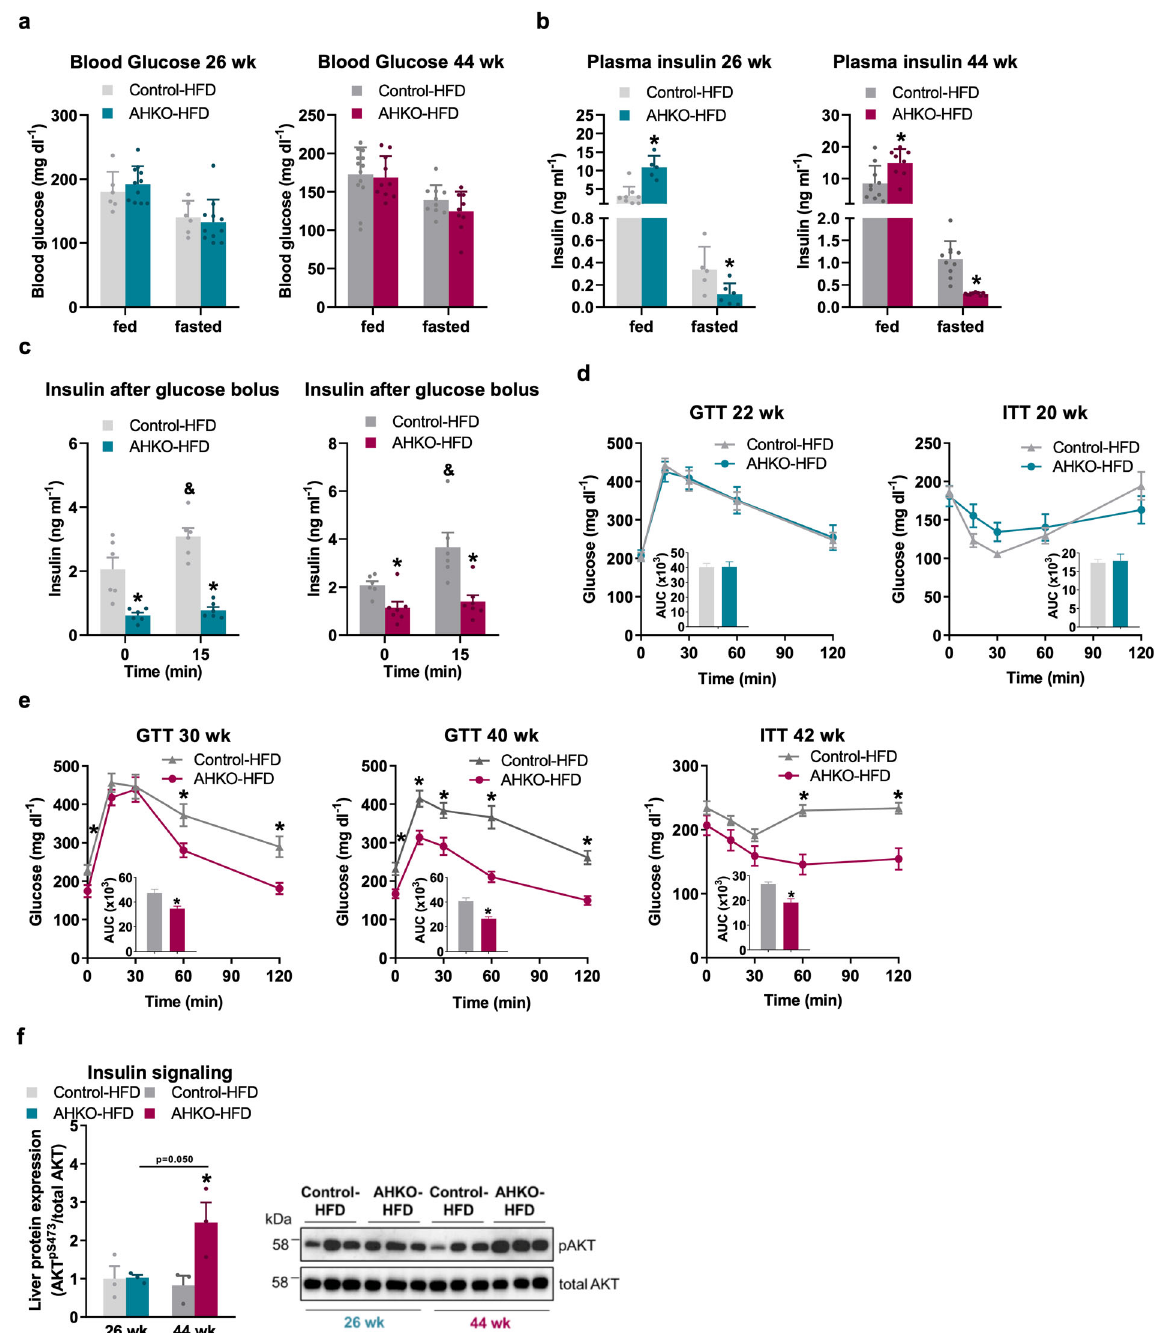
Fig. 6 Effects of adipocyte-speci fi c HSL deletion on systemic glucose homeostasis and insulin action. a Ad libitum fed and 12 h fasted blood glucose (M, 26 and 44 weeks, HFD, n = 5 – 9 animals/genotype). b Ad libitum fed and 12h fasted plasma insulin (M, 26 and 44 weeks, HFD, n = 5 – 9 animals/ genotype). c Plasma insulin levels following glucose bolus (1.6 g glucose kg − 1 body weight; M, 26 and 42 weeks, HFD, 6 h fasted, n = 6 – 7 animals/ genotype). d Glucose tolerance test (GTT; left) with 1.6 g glucose kg − 1 body weight (M, 22 weeks, HFD, 6 h fasted, n = 9 – 12 animals/genotype). Insulin tolerance test (ITT; right) with 0.75 IU insulin kg − 1 body weight (M, 20 weeks, HFD, 4 h fasted, n = 8 – 11 animals/genotype). e GTT (left, middle) with 1.6 g glucose kg − 1 body weight (M, 30 and 40 weeks, HFD, 6 h fasted, n = 9 – 12 animals/genotype). ITT (right) with 0.75 IU insulin kg − 1 body weight (M, 42 weeks, HFD, 4 h fasted, n = 9 – 10 animals/genotype). f Insulin signaling in liver of middle-aged and aged control and AHKO mice. Mice were injected with 0.75 IU insulin kg − 1 body weight and tissues were collected after 15 min. Left: quanti fi cation of phosphorylation of AKT pSer473 /total AKT (M, 26 and 44 weeks, HFD, 12 h fasted, n = 3 animals/genotype). Right: a representative immunoblot. Data represent mean ± SEM. Statistical signi fi cance was determined by Student ’ s two-tailed t test. P < 0.05: * for effect of genotype; & for effect of treatment.